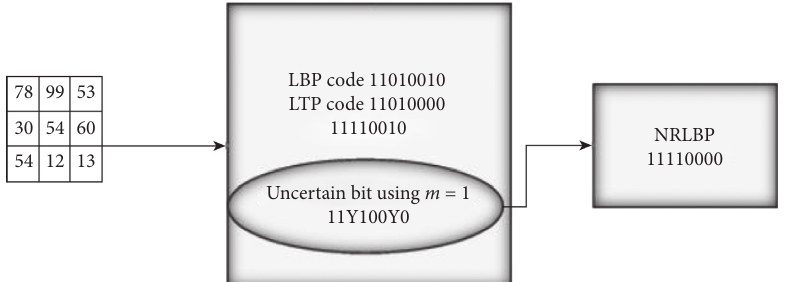
Figure 1: NRLBP encoding scheme in addition to comparison of LBP and LTP. NRLBP uniform code is formed by finding the uncertain bit Y at m � 1, and s is chosen as 2 for LTB and NRLBP.